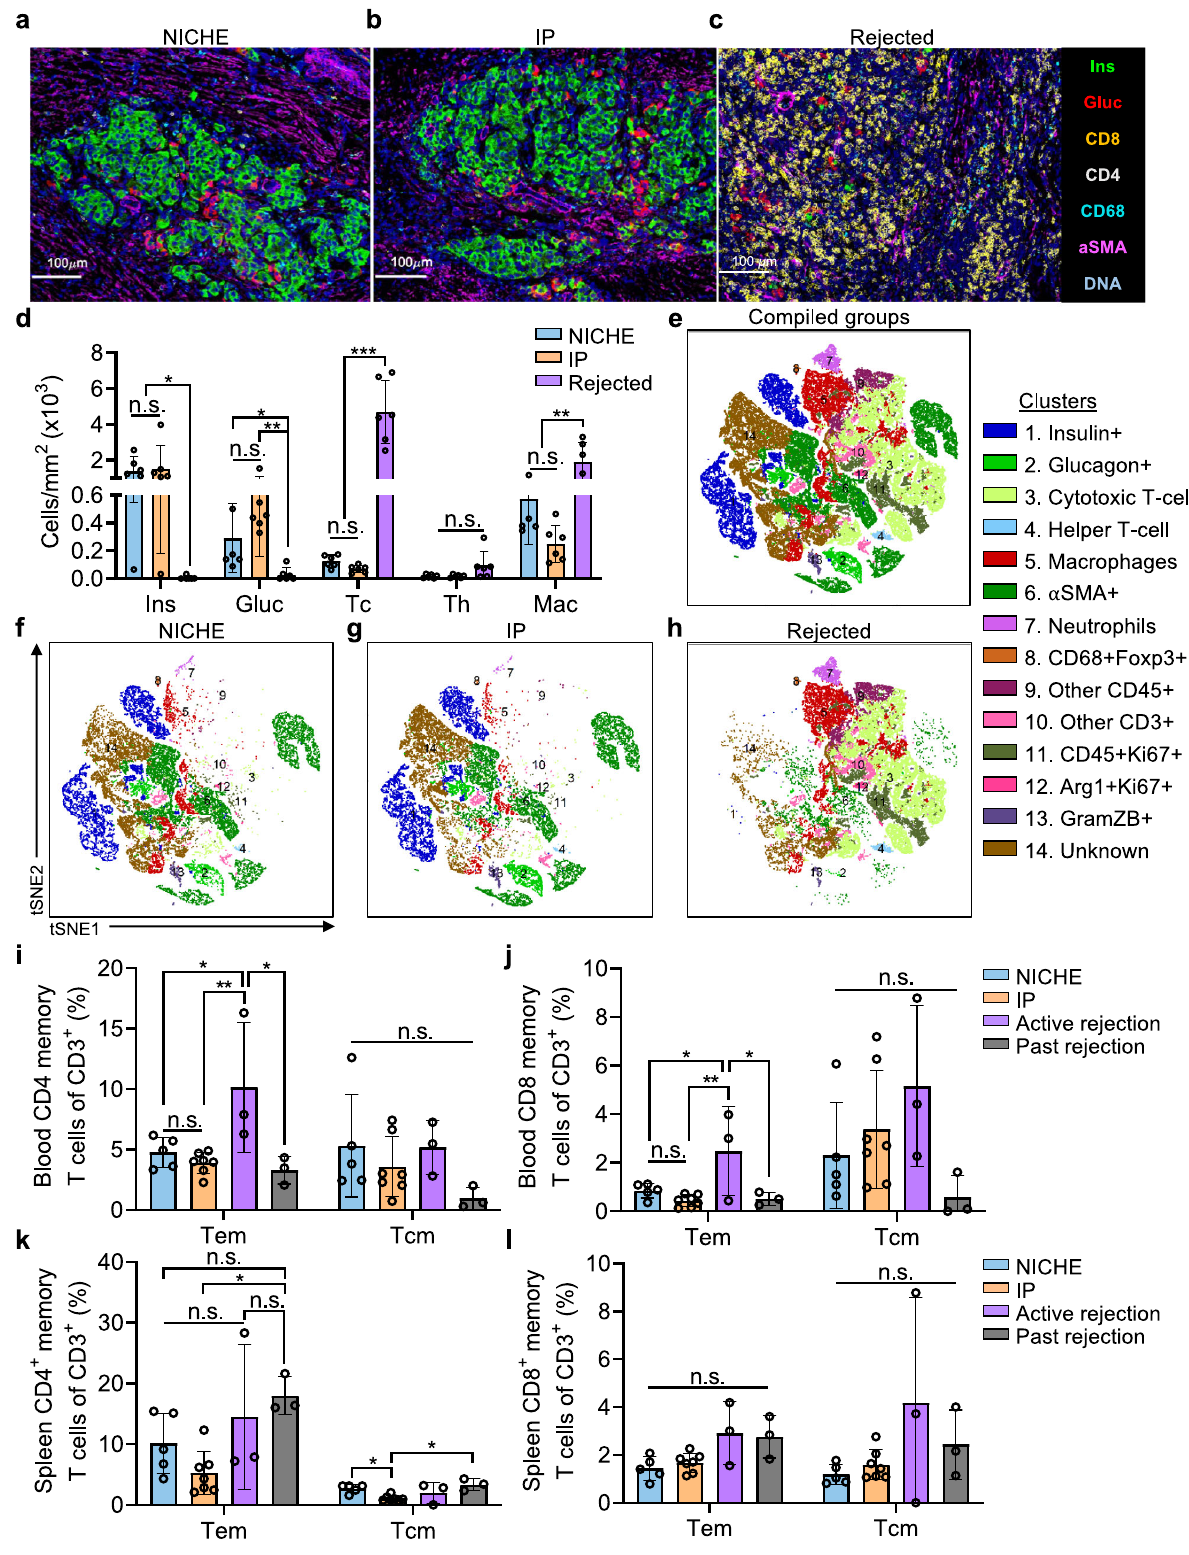
Fig.4|ImmunomodulationwithNICHEandIPdelivery. Imagingmasscytometry (IMC) of cell reservoir tissues from a NICHE, b IP, and c rats with rejected grafts. d IMC cell populations quanti fi cation ( n =6), mean±SD, one-way ANOVA with Tukey ’ s multiple comparisons test per population (* p <0.05; ** p